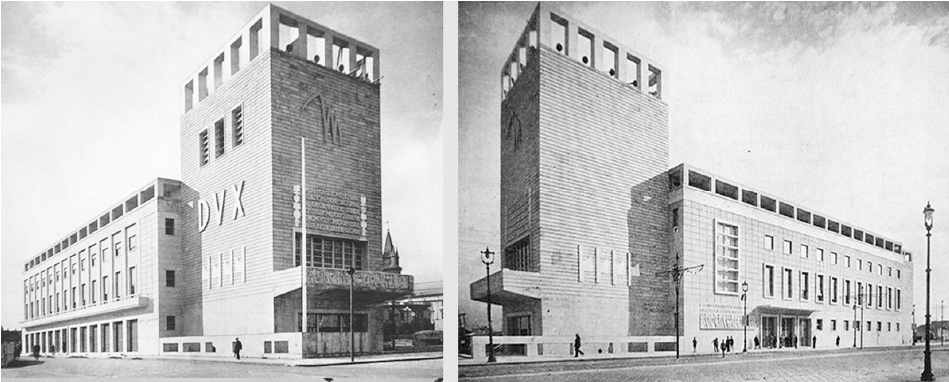
Figure 6. The Fascist House of Messina